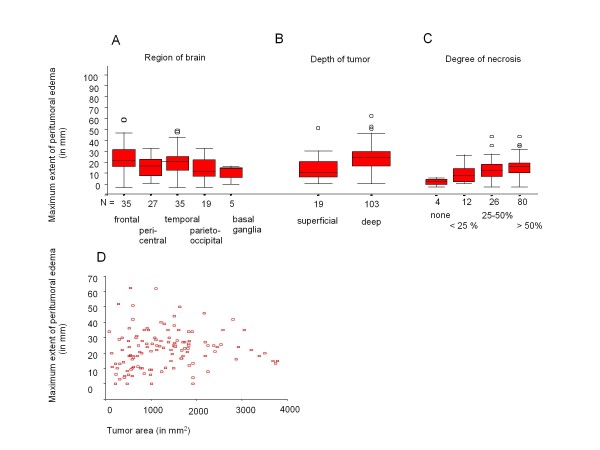
Confounding factors.